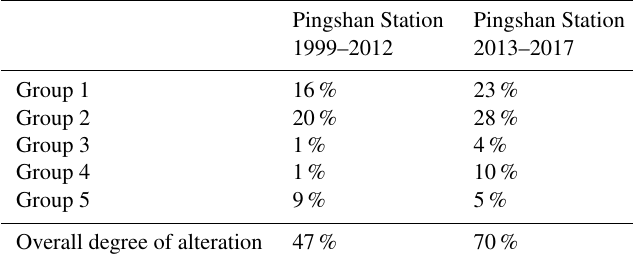
Table 6. Overall degree of alteration of five groups of IHA